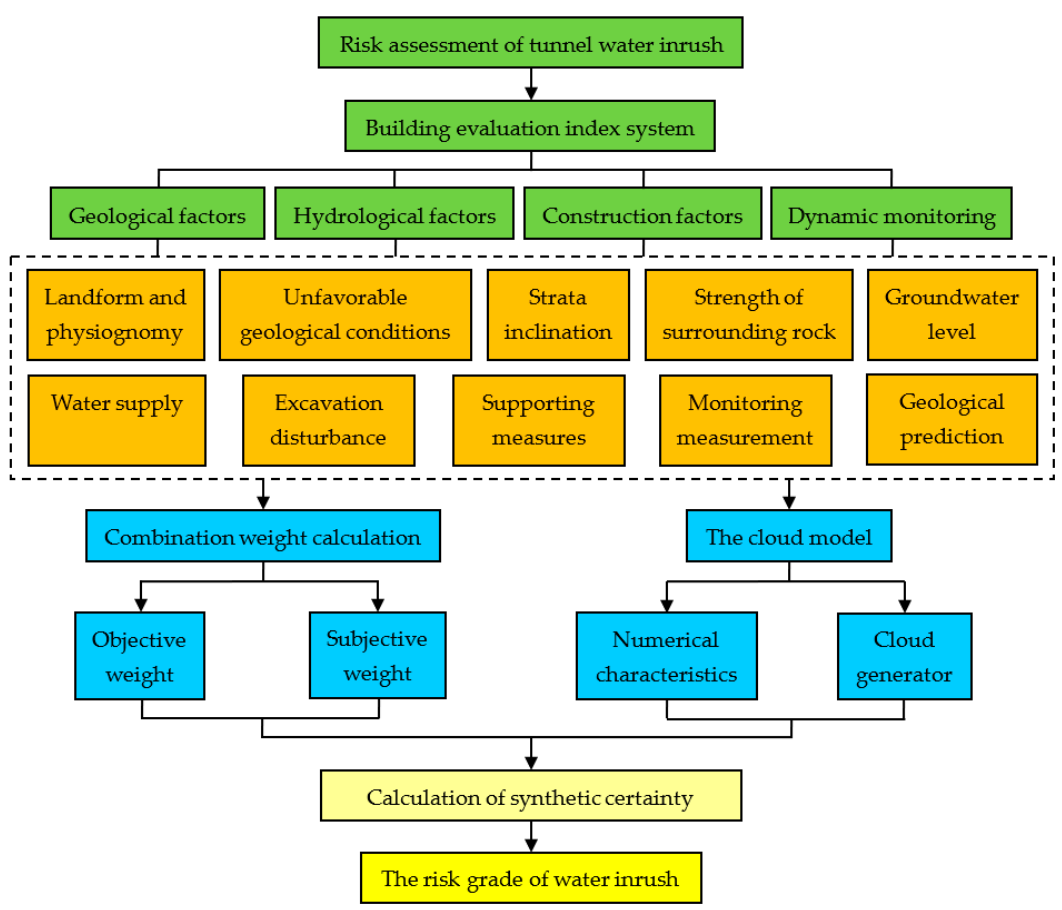
Figure 4. The risk assessment process of tunnel water inrush based on a normal cloud model.